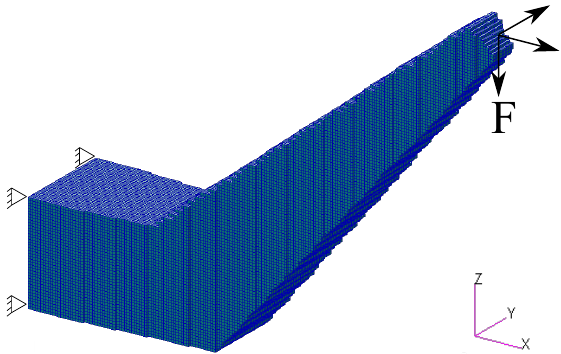
Figure 8. Topology Optimization (TO) design volume and boundary conditions.